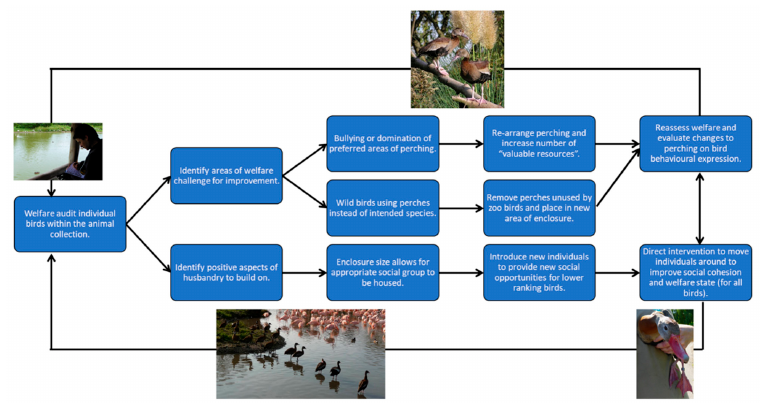
Figure 6. Conducting a welfare assessment on an example species of waterfowl, in this case a whistling duck, using knowledge of ecological needs (i.e., perching and flock-living) to guide evaluation of biologically suitable husbandry and to identify areas of husbandry improvement and welfare challenge. Photo credit (perching whistling ducks): J. Harteman (used with permission).